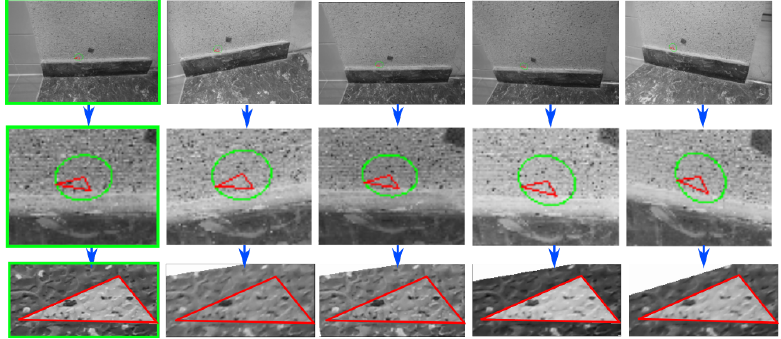
Figure 6. An example of ROI on each images. ( Second line ): triangle ROI projected on images. ( Bottom line ): normalized triangle ROIs. In the green frame is the master image.